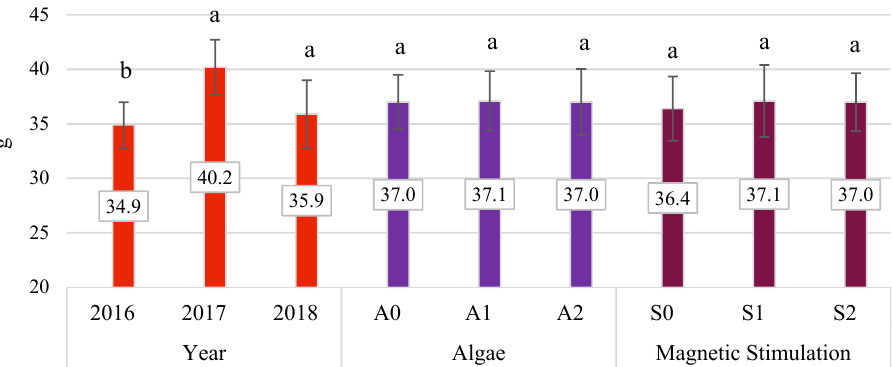
Figure 10. Effect of the alga dose and the MF exposure dose on oat grain weight in the panicle (in grams) from 2016 to 2018. According to Tukey’s HSD (honest significant difference) test, the means marked with the same letter were not significantly different at α ≤ 0.05.